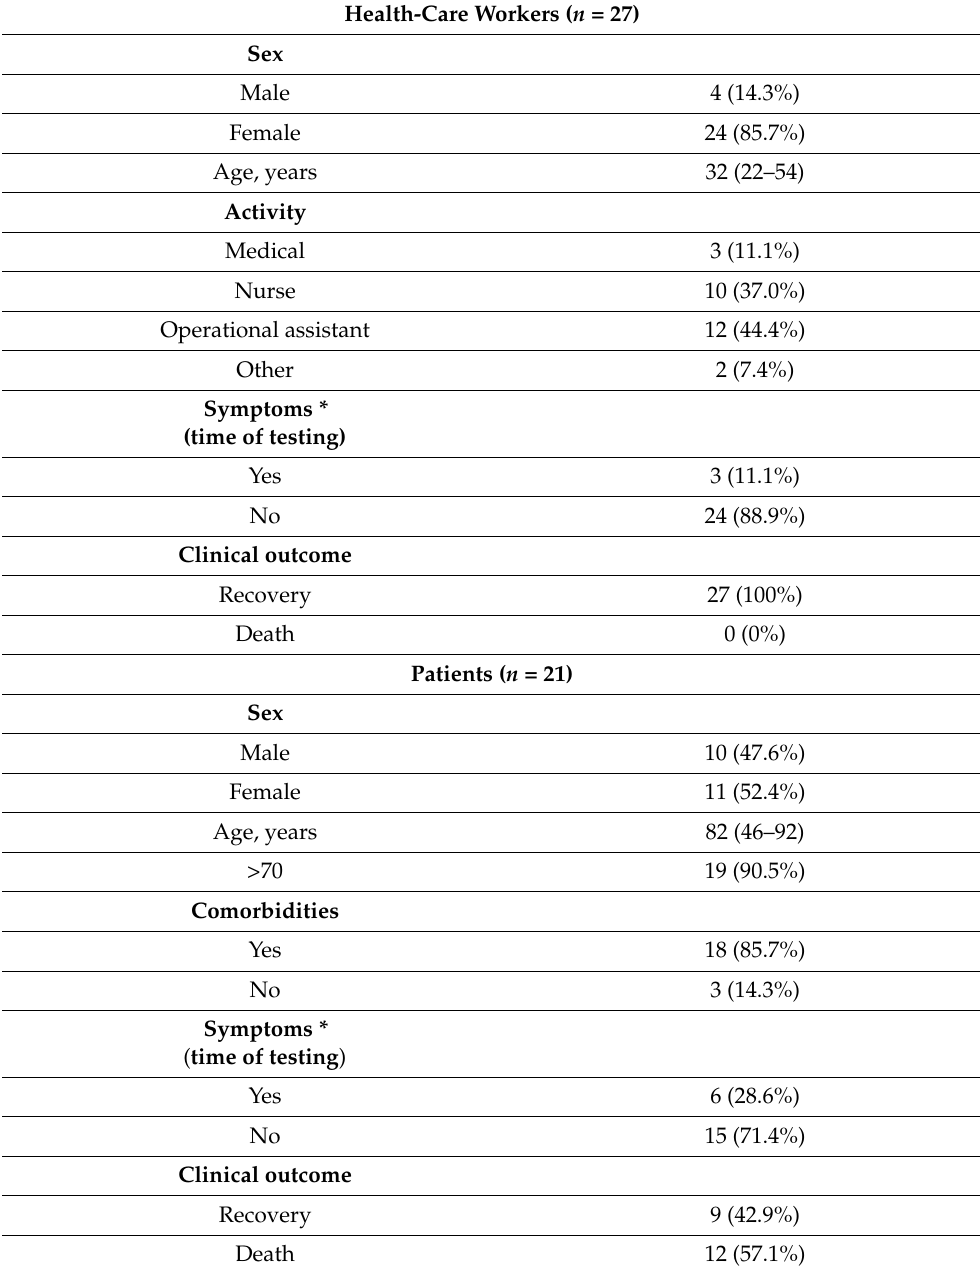
Table 1. Descriptive characteristics of outbreak-related health-care workers ( n = 27) and patients ( n = 21) testing positive for SARS-CoV-2 RNA in a large hospital in Portugal, Summer,